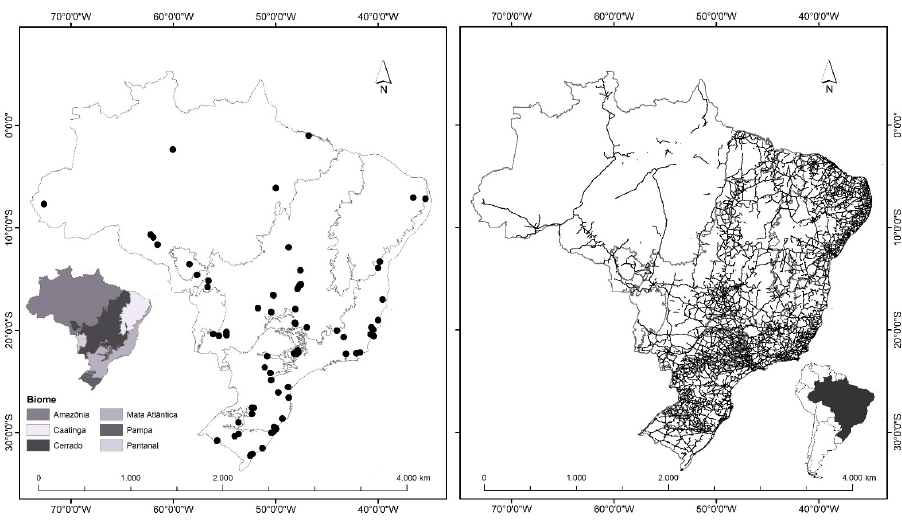
Figure 1. Brazilian biomes, the location of road-kill studies used in the analysis (black dots, left); and paved road network (right).